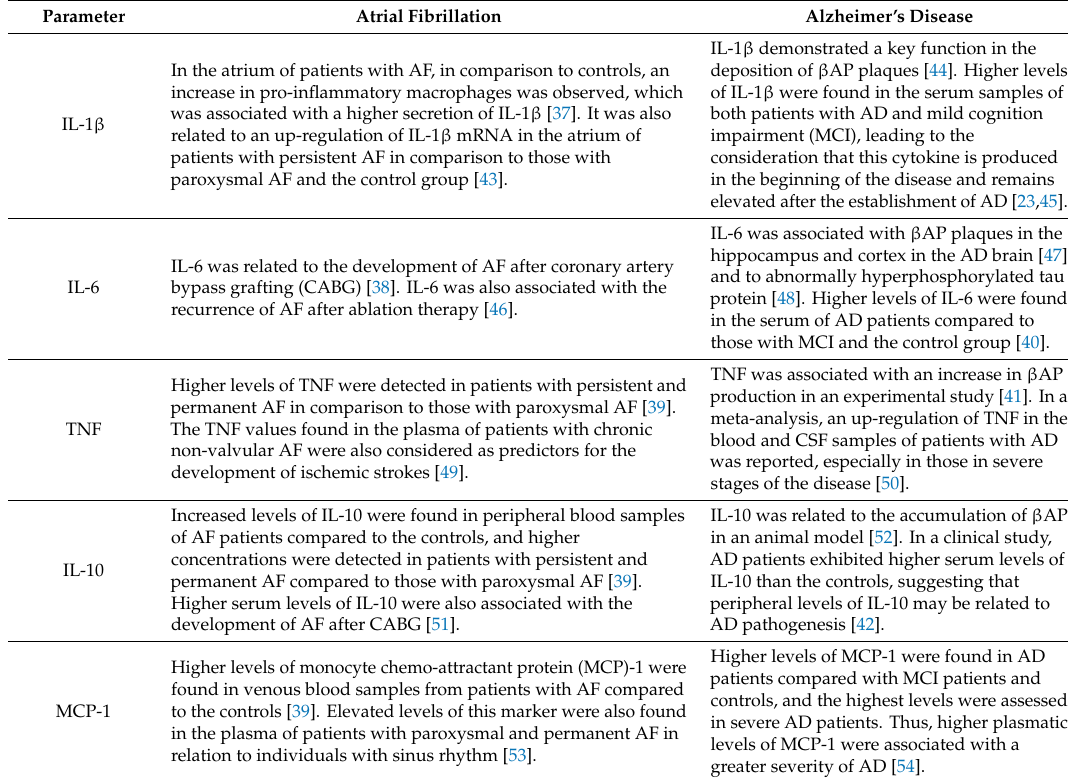
Table 1. Main inflammatory molecules related to both atrial fibrillation (AF) and Alzheimer’s disease (AD). Parameter Atrial Fibrillation Alzheimer’s